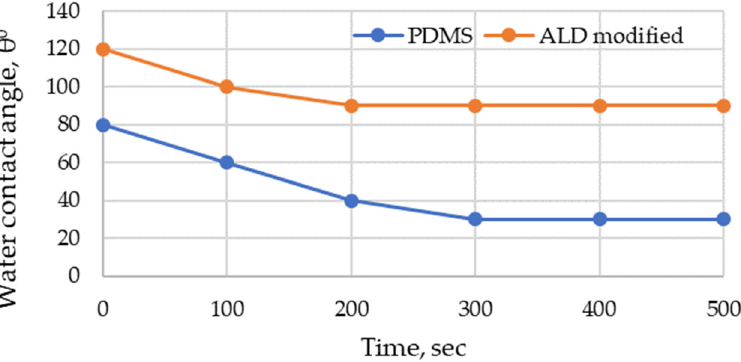
Figure 11. Water contact angle values obtained from PDMS and ALD-modified PDMS membranes.